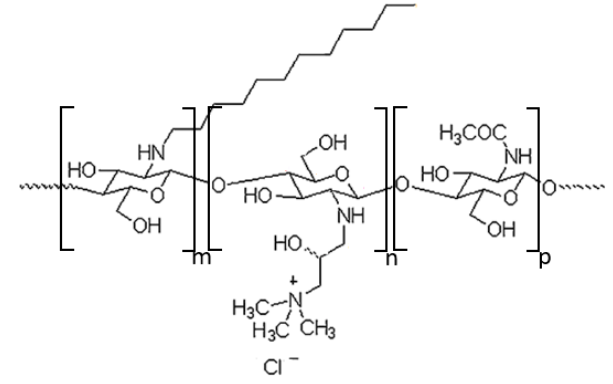
Figure 1. Scheme of chitosan derivative (CChit-C12) containing quaternary ammonium and N -dodecyl groups.